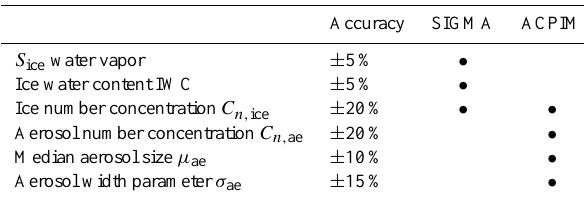
Fig. 4. Experimental measurements and model calculations for one experiment with hematite aerosol at low temperatures (HALO05 18) and one experiment with graphite spark generator soot aerosol at intermediate temperatures (HALO06 26). The aerosol surface size distributions for these experiments are given in Fig. 2. Panels from top to bottom show ice saturation ratio S ice derived from APicT water vapor content, ice water content IWC inferred from APicT water vapor and APeT total water measurement, ice number concentration C n, ice measured Figure 4. Experimental measurements and model calculations for one experiment with 3 by the WELAS optical particle counter as well as gas pressure p , gas temperature T g , and AIDA wall temperature T w . For a range of hematite aerosol at low temperatures (HALO05_18) and one experiment with graphite spark 4 accommodation coefficients α ice , results from the SIGMA model IWC SIGMA for the evolution of ice water content and from the ACPIM model for the evolution of S ice are included in the respective panels. The dotted line indicates the start time of the experiment, i.e., the start generator soot aerosol at intermediate temperatures (HALO06_26). The aerosol surface size 5 of pumping, while the dashed dotted line depicts the ice onset time inferred from SIMONE forward scattering data. distributions for these experiments are given in Fig. 2. Panels from top till bottom show ice 6 Table 4. Accuracies of the experimental data sets used for the saturation ratio SIGMA and ACPIM model uncertainty analysis based on the Monte Carlo method. The points mark if the data set is randomly varied in the uncertainty analysis of the respective